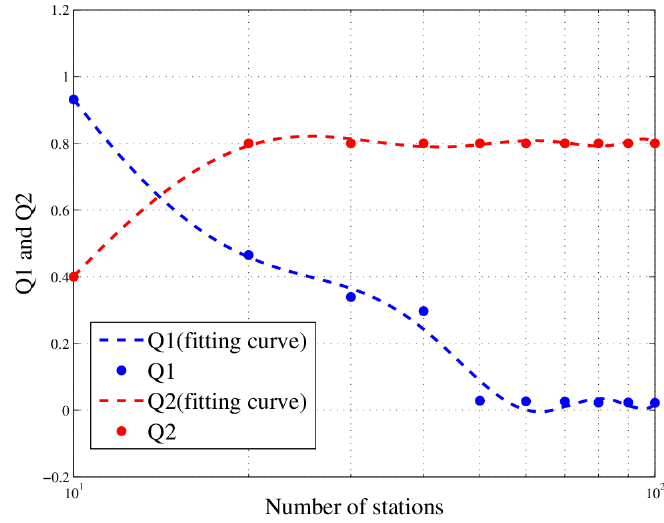
Q Q Figure 17. 1 and 2 in different scenario (with 5 tasks). Figure 17. Q 1 and Q 2 in different scenario (with 5 tasks).